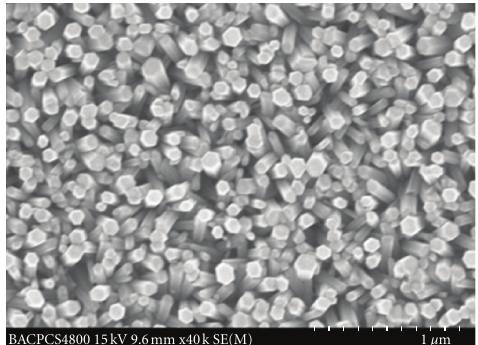
Figure 2: SEM top-view image of the ZnO nanorods.